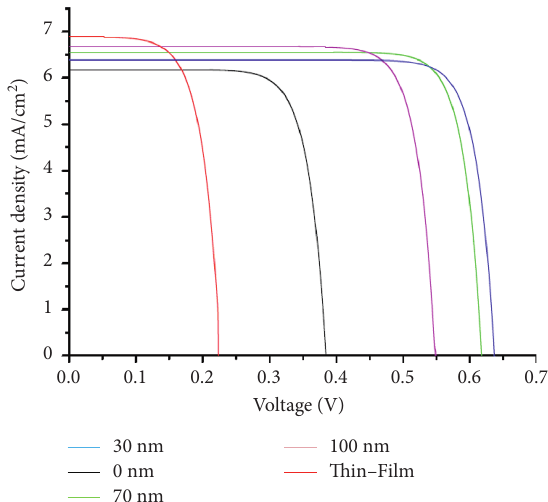
Figure 9: Current density as a function of voltage for thin-film (red curve), CdS shell thickness of 30nm (blue curve), CdS shell thickness of 70nm (green curve), CdS shell thickness (black curve), and CdS shell thickness of 100nm (cyan curve). Table 3: The numerical values of Jsc, Voc, FF, and EFF for thin-film and core-shell nanowire devices. Model sol.